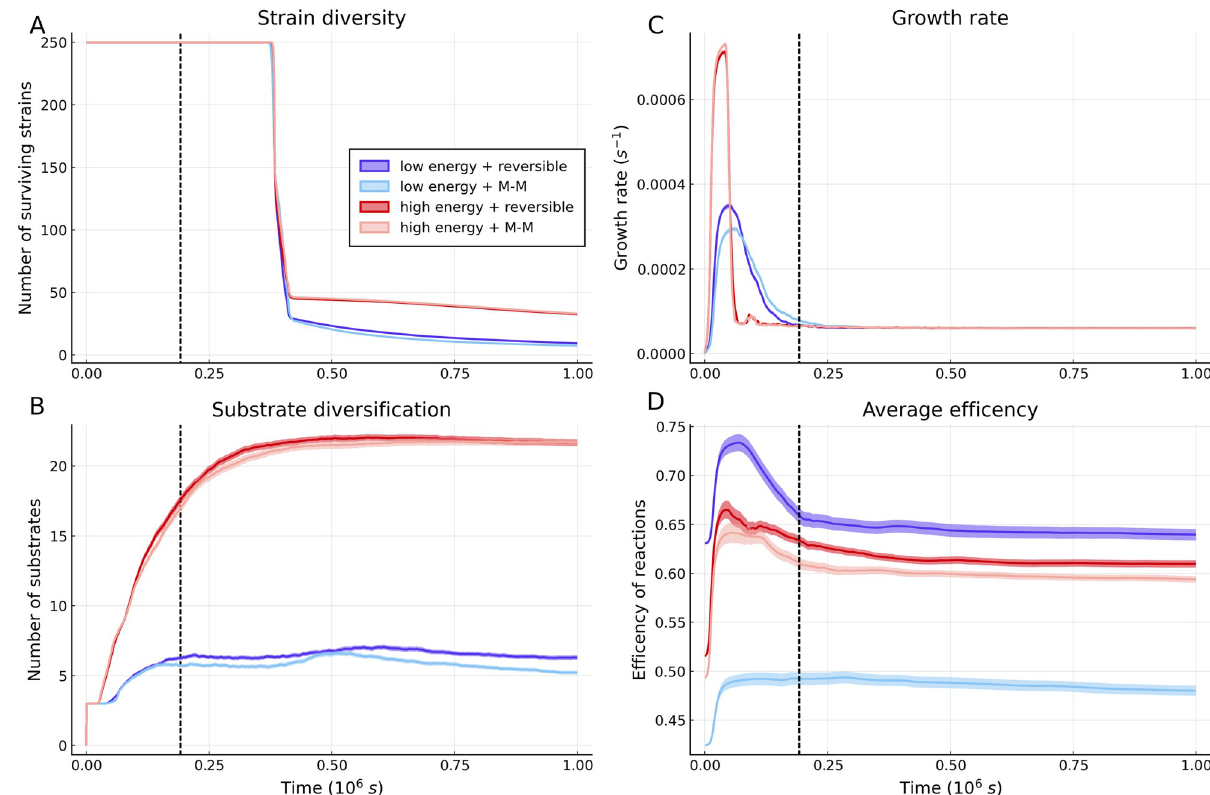
Fig 4. Averaged assembly patterns across communities. Averages (across 250 simulations) of key quantities over time are shown (with 99% confidence intervals) for the four regimes considered in Fig 3. To better reveal the dynamics only a small initial time window is shown. A : Average species diversity over time. The dashed black line shown in all four plots marks the time point where 75% of species have dropped below the threshold where they can no longer significantly impact the metabolite dynamics. B : Substrate diversification plateaus for all regimes at approximately this time. C : Across all regime growth rate rapidly peaks, the peak is both earlier and higher for high free-energy (labile) substrates. D : Dynamics of the average reaction efficiency, i.e. the fraction of the free energy change that is used to generate ATP rather than being dissipated (full definition provided in S1 Appendix). The position of the peaks can be seen to match the position of the corresponding growth rate peaks in plot C . The four plots use the same parameters for the respective regimes as are used in Fig